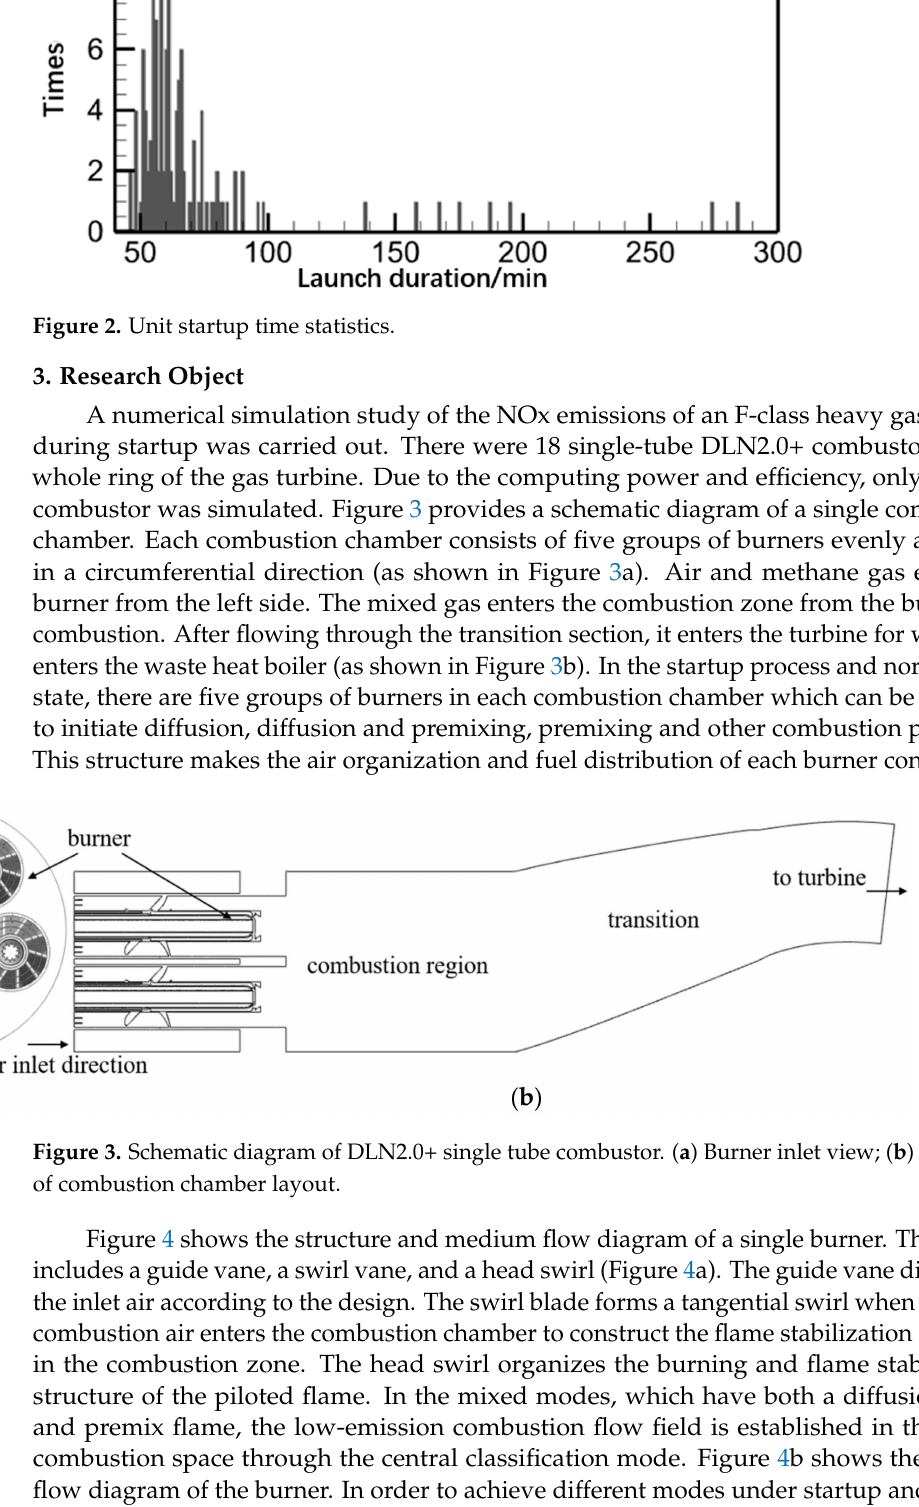
Figure 3. Schematic diagram of DLN2.0+ single tube combustor. ( a ) Burner inlet view; ( b ) Side view of combustion chamber layout.